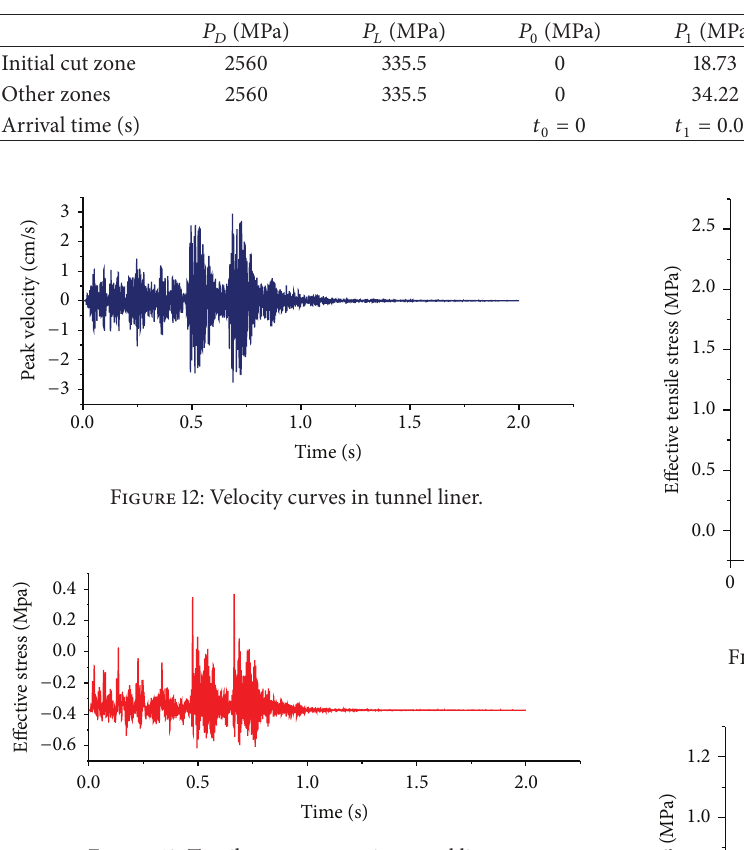
Table 4: The detail value of every stage pressure and arrival time.